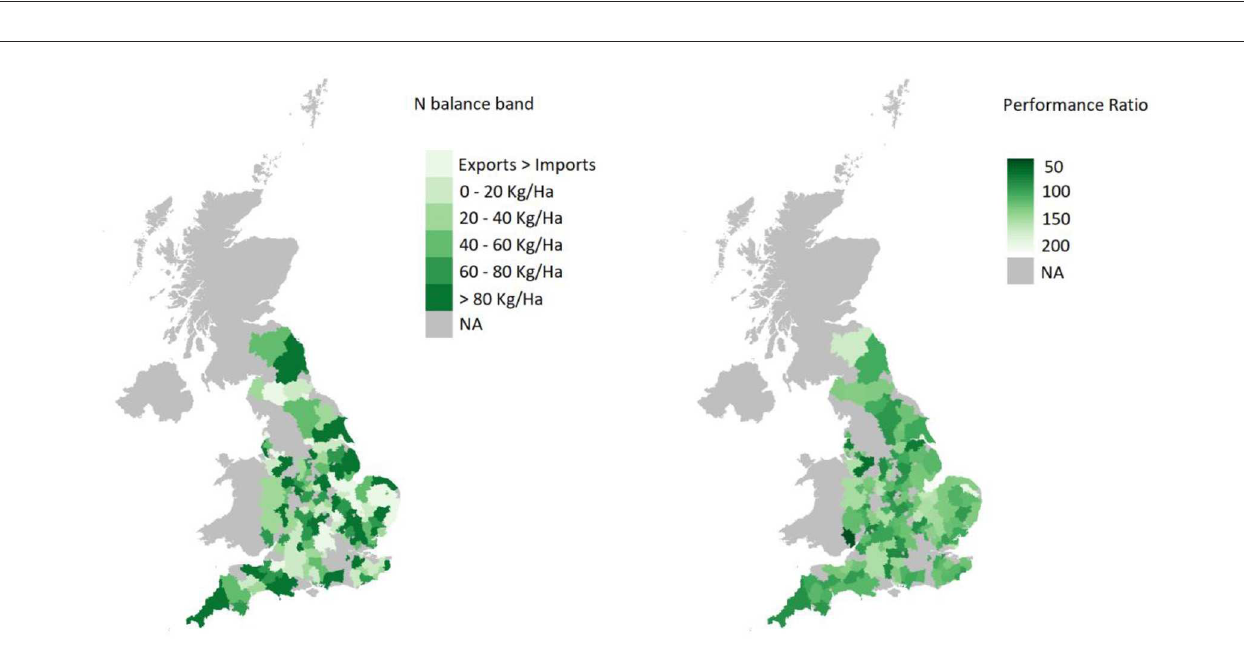
FIGURE2 Local Authority (NUTS4) polygons of England, displaying modal values of N balance band (left panel) and mean values of farm business performance ratio (right panel) where FBS data are